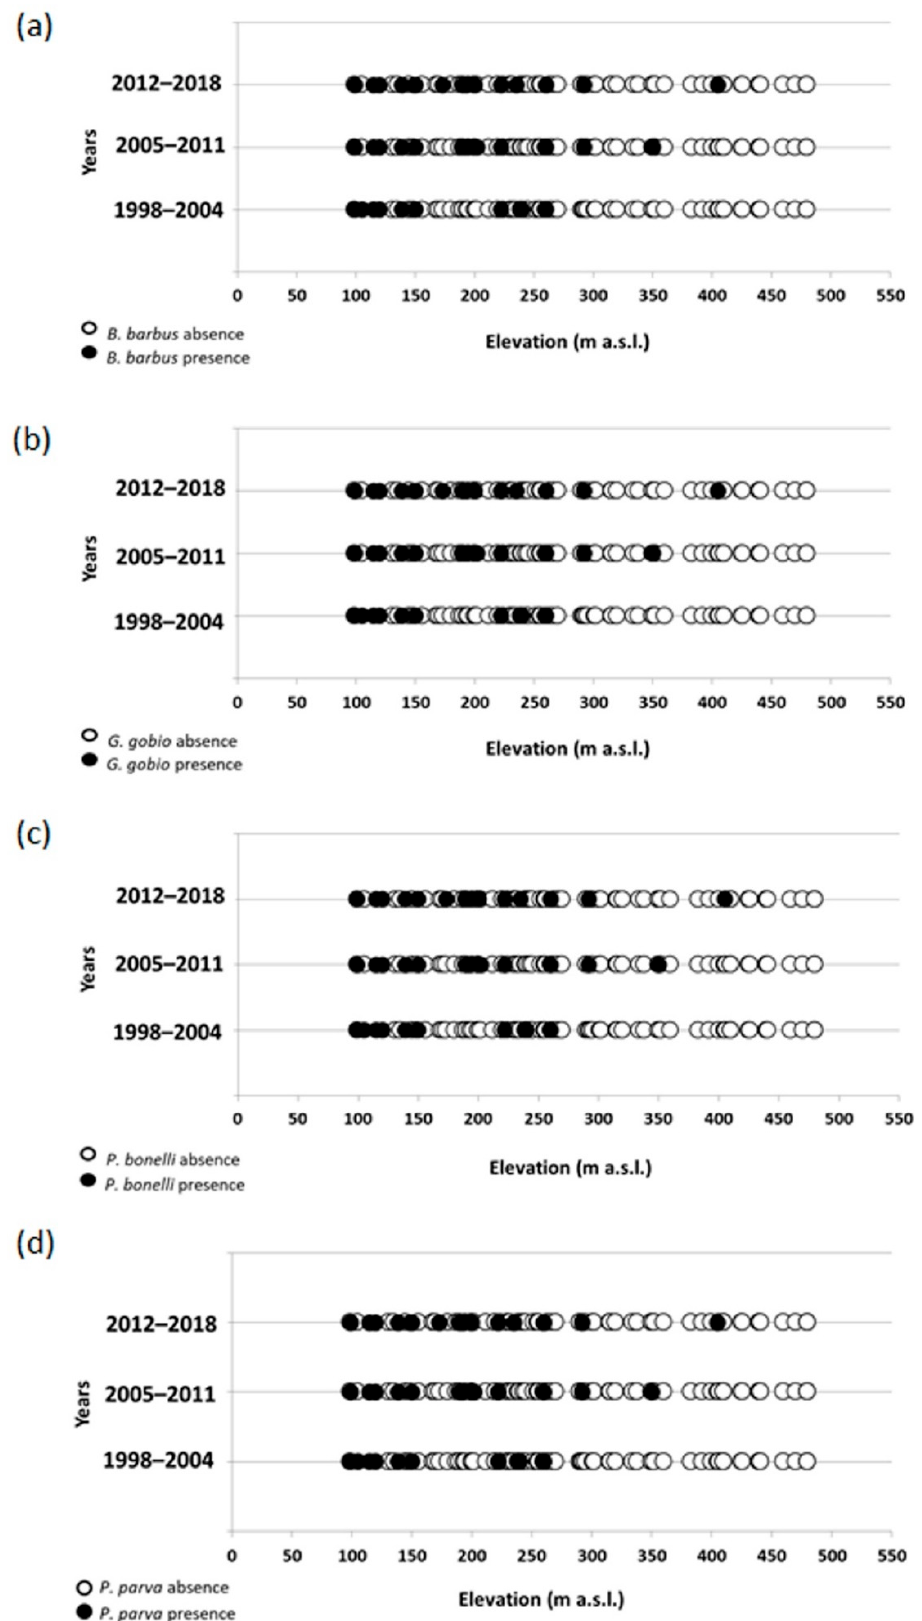
Figure 4. Occupancy elevation plots for: ( a ) B. barbus , ( b ) G. gobio , ( c ) P. bonelli , ( d ) P. parva .